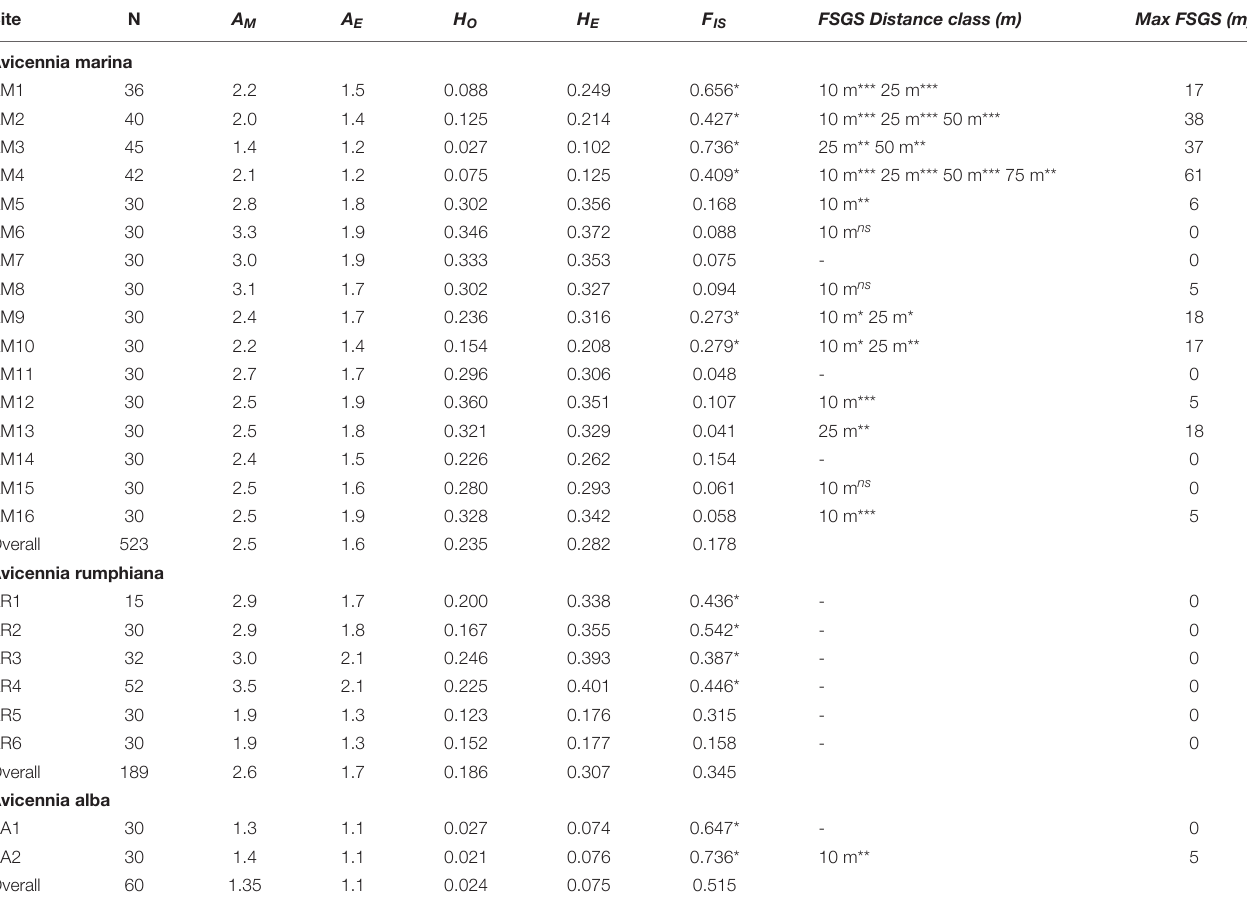
TABLE 2 | Population genetic variables of Avicennia transects in mangrove areas along Tablas Strait and Western Leyte (Philippines).